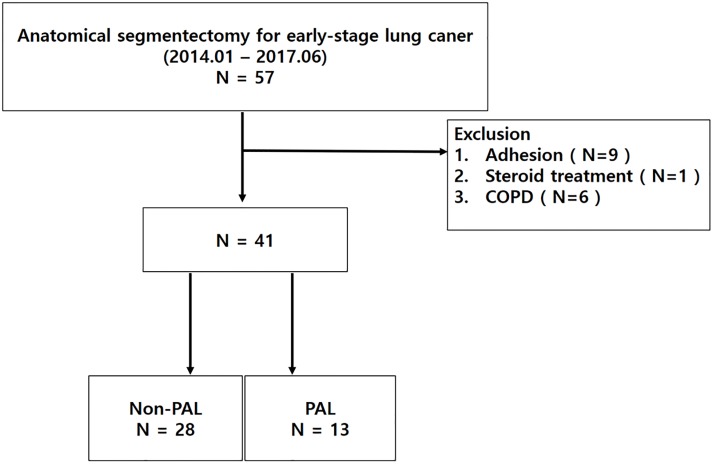
Flowchart for patient selection.